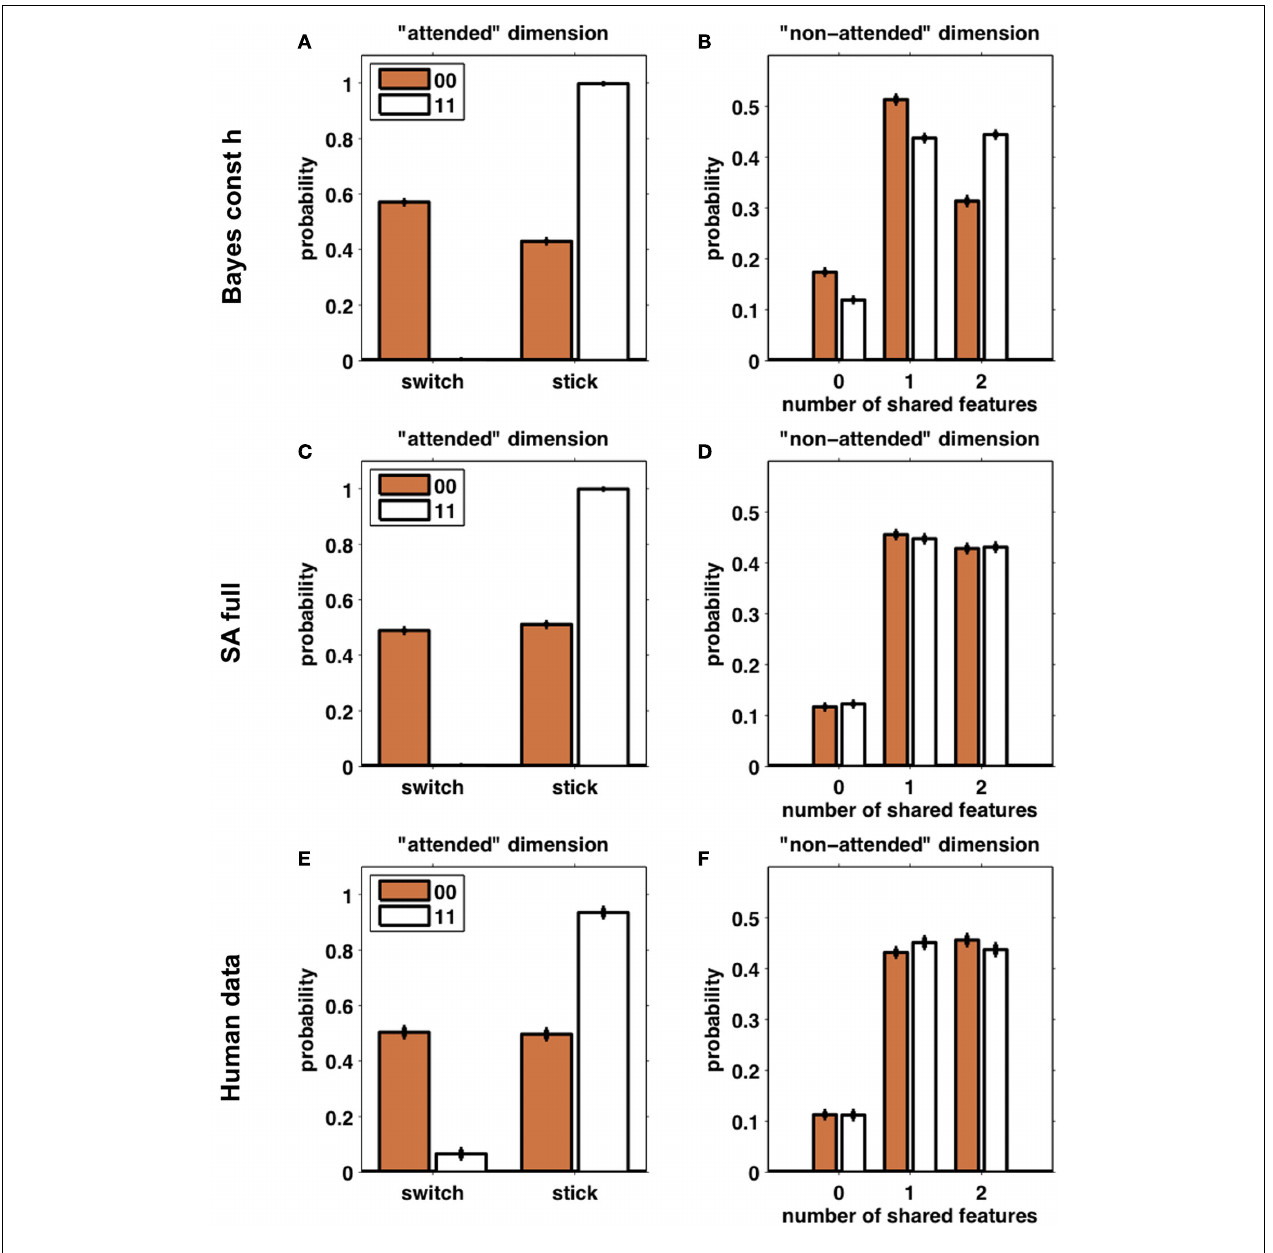
(orange) or two wins (white). Right column (B,D,F) : the number of shared features between the third choice and the second choice, in the putatively unattended dimensions, divided according to the outcomes of the last two trials (orange – two losses; white – two wins). Error bars are